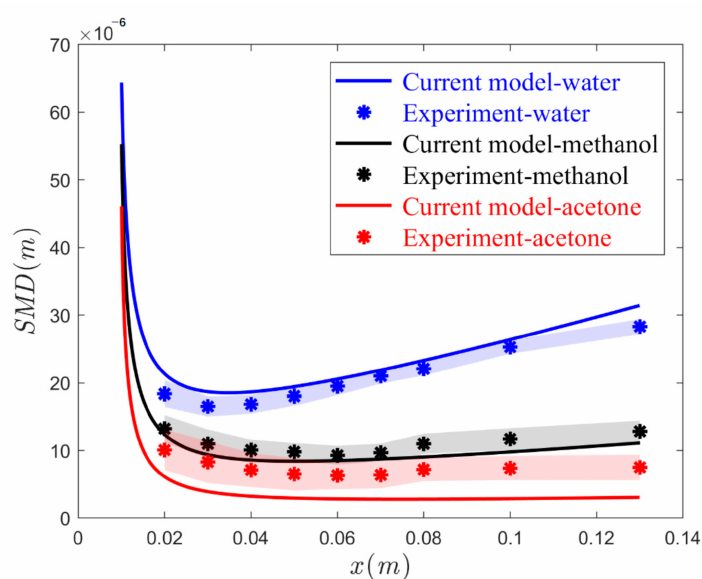
Figure 4. Experimental data (via laser di ff raction by Spraytec) and current model results on SMD along the atomization axis for the three liquid feeds of water, methanol and acetone at u g = 125 m / s and u l = 2.5 m / s. Shaded areas show the error associated with each